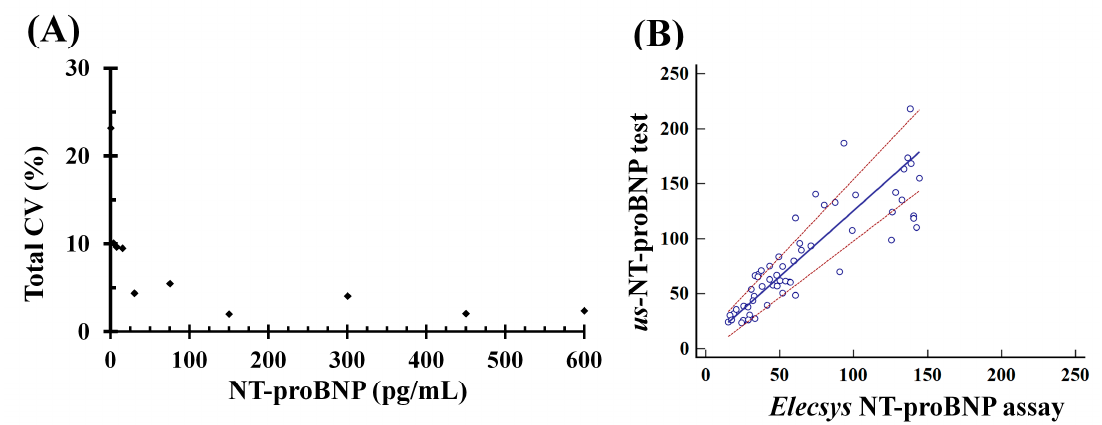
Figure 2. ( A ) Inter-assay precision profiles for the us -NT-proBNP test; ( B ) Passing and Bablok regression analyses of results for 58 clinical samples (range: 26.3–163.3 pg/mL) by us -NT-proBNP test and NT-proBNP assay.